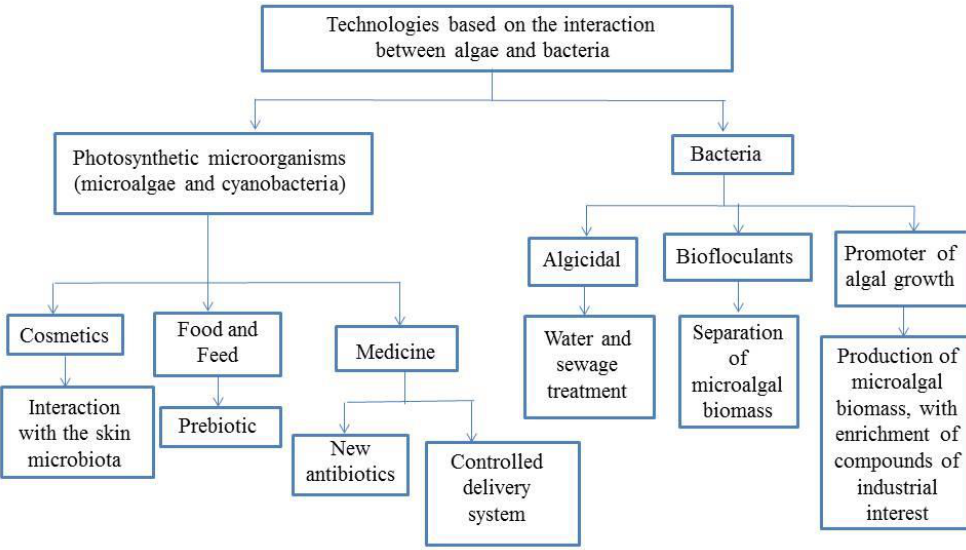
Figure 2. Diagram about how the study of microalgae-bacteria interactions can result in bioprod-